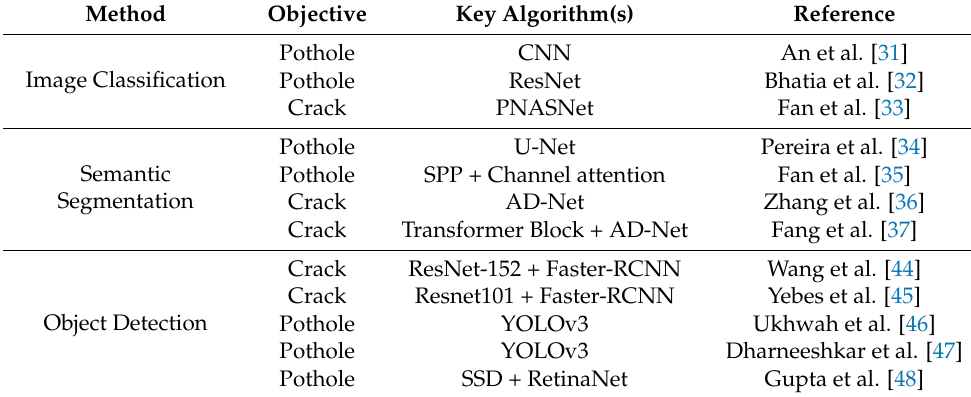
Table 2. Summary of road damage detection papers in deep learning.